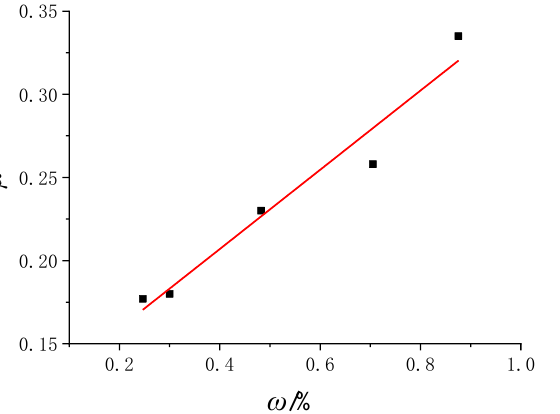
Figure 11. The relationship between the Poisson ’ s ratio and the rock water content.